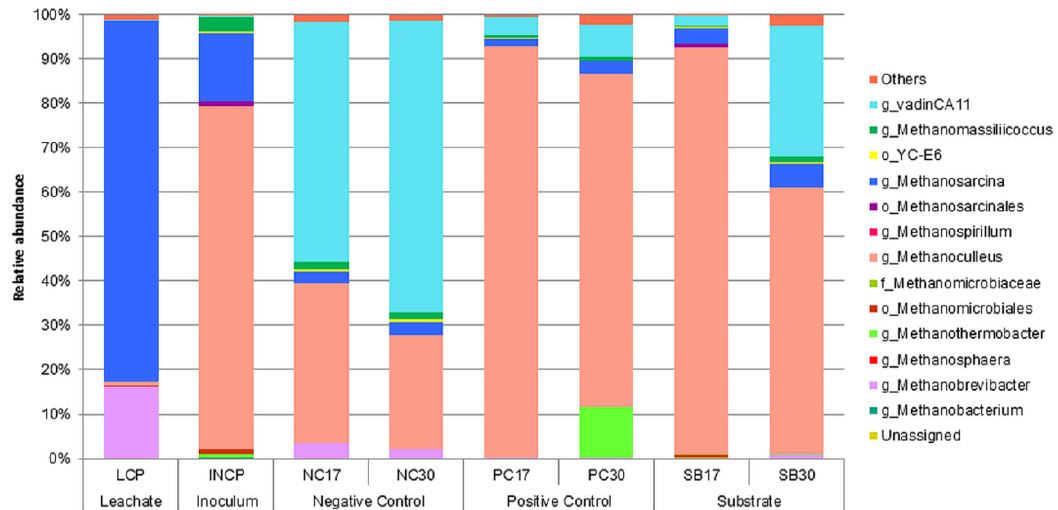
Figure 4. Relative abundance (%) of archaeal genera in the leachate (LCP), inoculum (INCP), and treatment groups (NC — negative control; PC — positive control; SB — substrate; 17-on 17 days; 30-on 30 days).